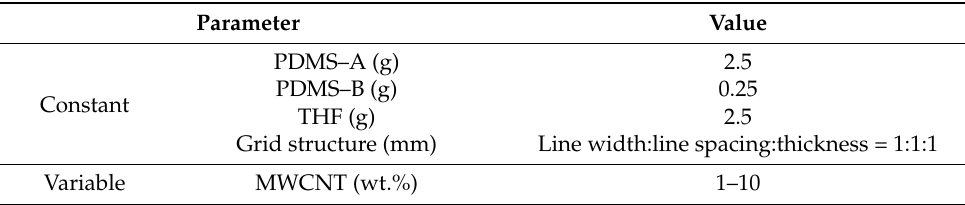
Table 1. Parameter design for different doping ratios of multi–walled carbon nanotubes